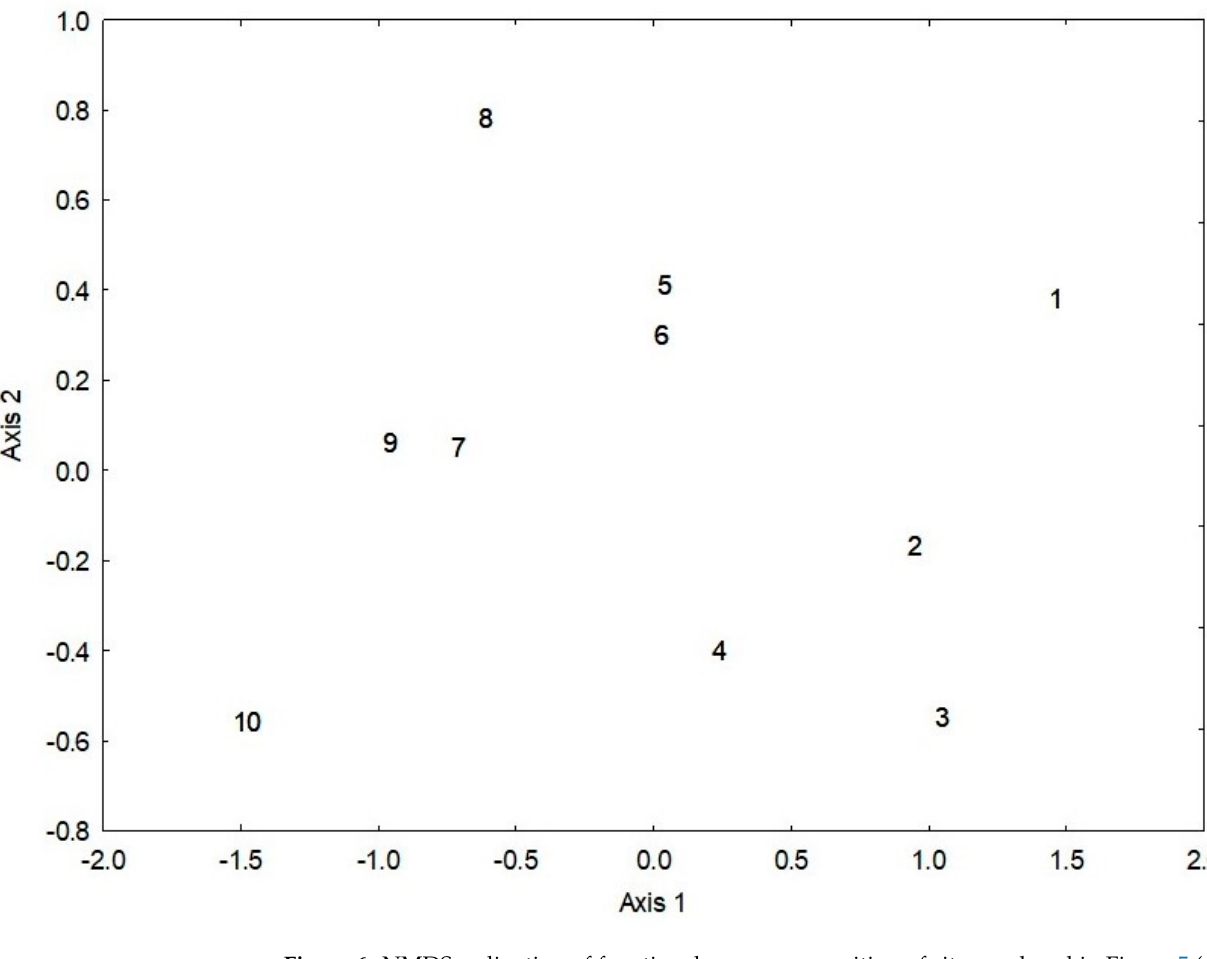
Figure 6. NMDS ordination of functional group composition of sites analysed in Figure 5 (points 1–10) representing an environmental gradient from a Mediterranean grassland (1) to a forest at high latitude (10). 2D Stress = 0.02.